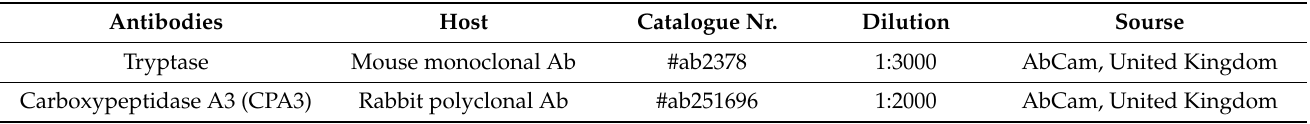
Table 2. Primary antibodies used in this study.